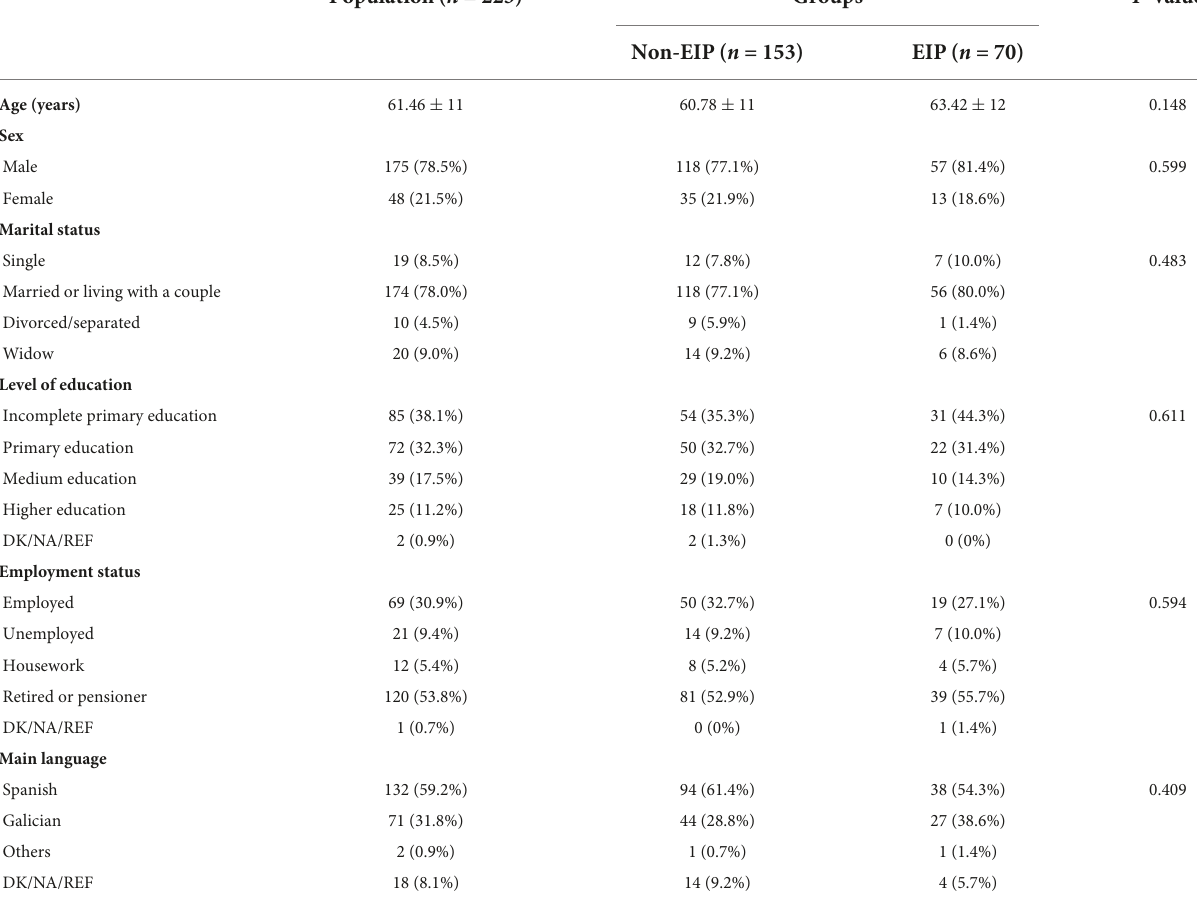
TABLE 1 Characteristics of the